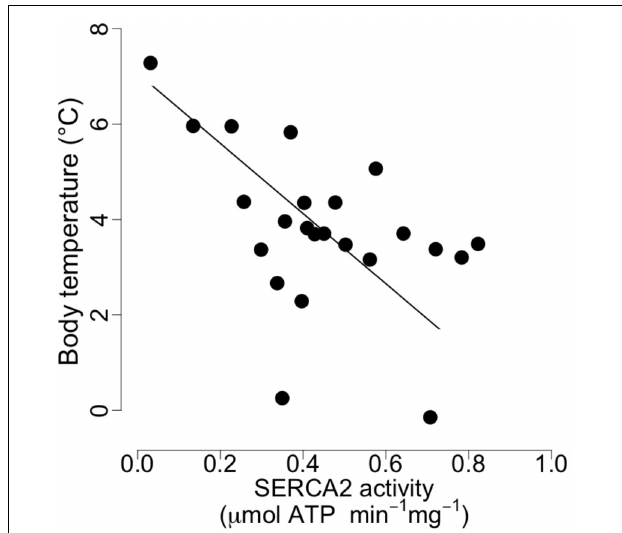
FIGURE 3 | Body temperature as a function of cardiac sarcoplasmic reticulum (SR) Calcium ATPase 2a (“SERCA”) activity in garden dormice during deep torpor (mid-hibernation). Regression statistics from linear ranged major axis analysis: intercept = 7.07, slope = –7.36, adjusted R 2 = 0.21, p = 0.01.